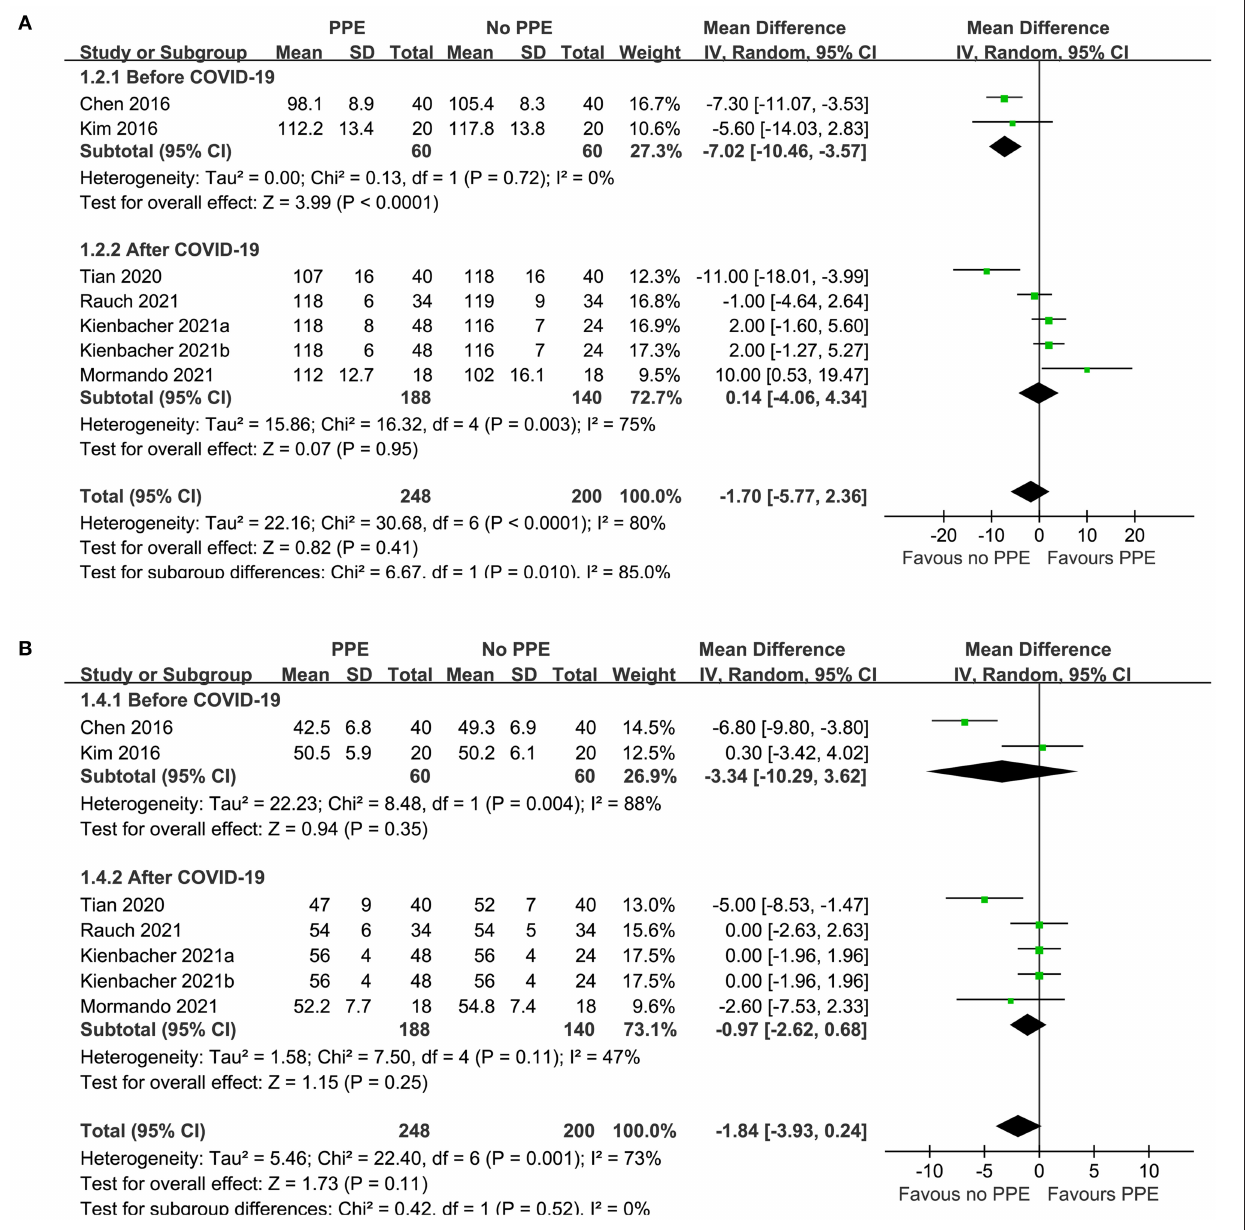
FIGURE 2 | Forest plots for the meta-analysis of the quality of chest compression in medical personnel with and without PPE. (A) Forest plots for the meta-analysis of the rate of chest compression in studies before or after COVID-19 and (B) forest plots for the meta-analysis the depth of chest compression in studies before or after